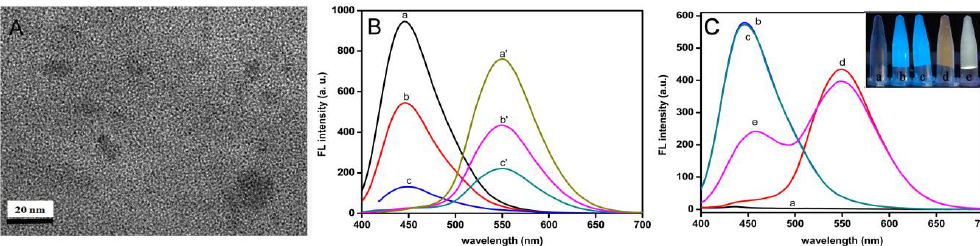
Figure 2. ( A ) The TEM of CQDs. ( B ) Fluorescence spectra of CQDs and ODB oxide (oxODB) at different excitation wavelengths (a, c′:365 nm; b, b′:380 nm; c, a′:400 nm). ( C ) Fluorescence spectra of CQDs, ODB, oxODB and their related mixtures (a: ODB, b: CQDs, c: CQDs + ODB, d: oxODB, e: CQDs + oxODB). oxODB is the product of the oxidation of ODB by hydrogen peroxide (the oxidation product of glucose) under horseradish peroxidase (HRP); the insert images are the corresponding fluorescence color under ultraviolet (UV) lamps of 365 nm.